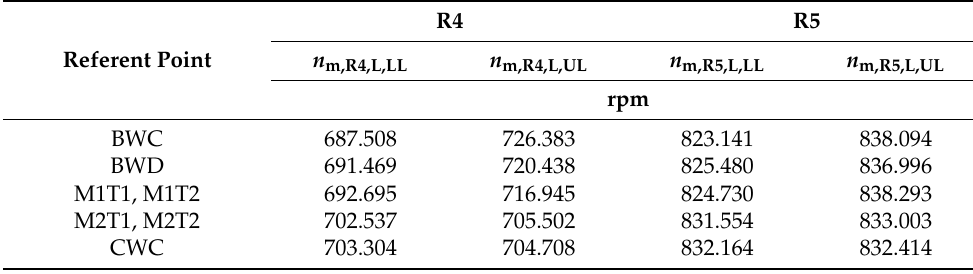
Table 8. Boundaries of the FREM resonant domains according to a L,per –EHO: